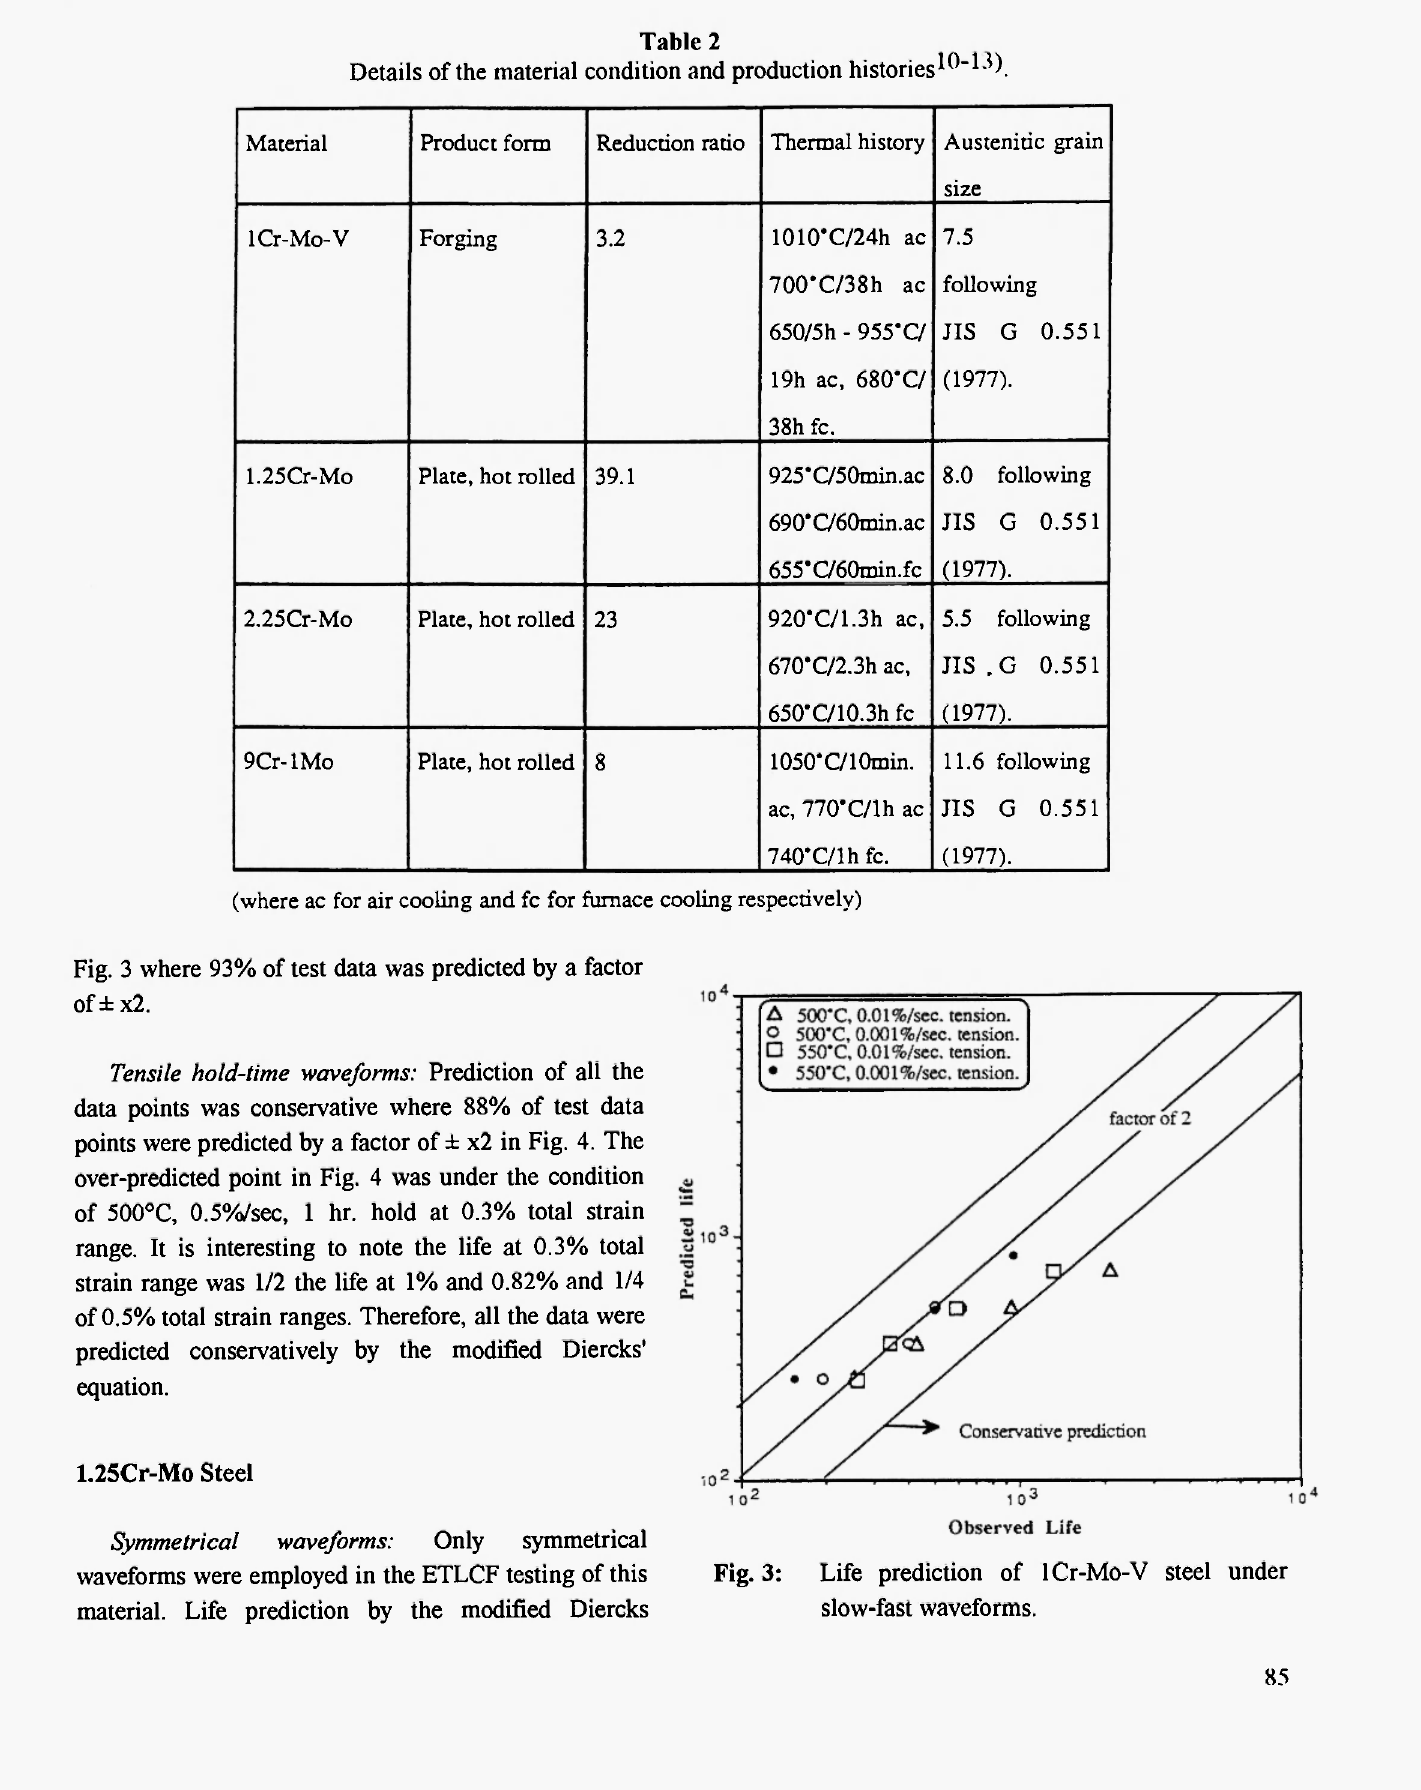
Fig. 3: Life prediction of lCr-Mo-V steel under slow-fast